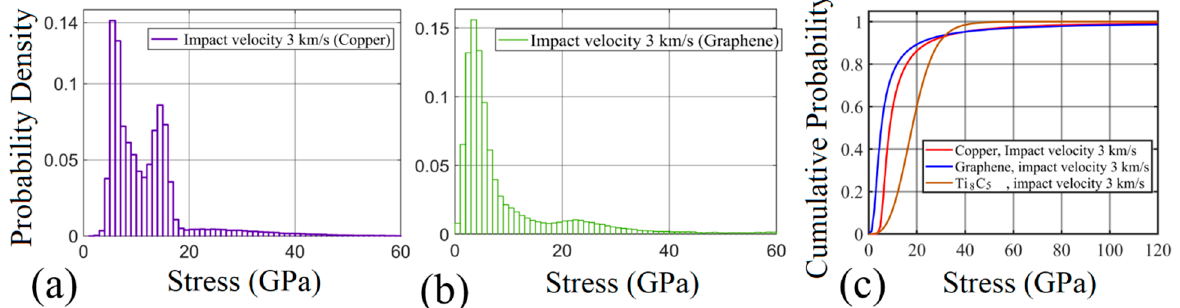
Figure 7. Stress distribution diagram for ( a ) copper and ( b ) graphene subject to an impact velocity of 3 km/s; ( c ) Cumulative density function (CDF) of the Von Mises atomic stress distribution before the crack initiation for different nanosheets under an impact velocity of 3km/s (red, blue and brown lines represent copper, graphene and Ti 8 C 5 , respectively).